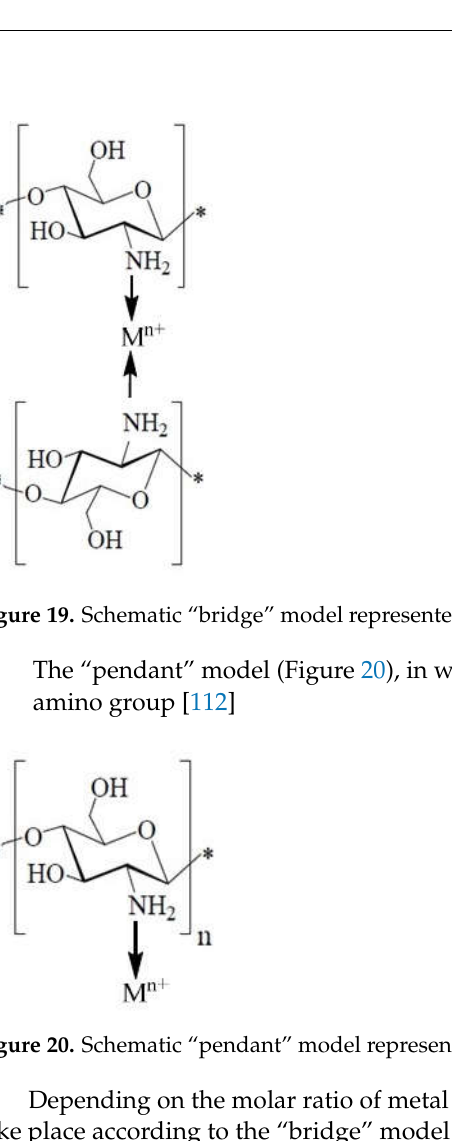
Figure 20. Schematic “pendant” model represented according to [112].